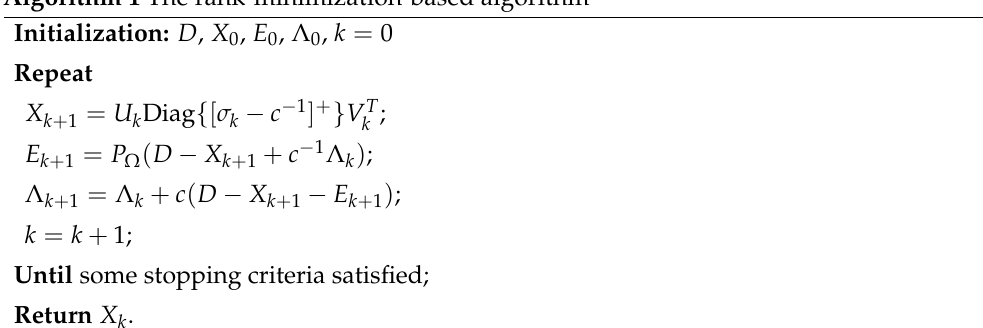
Algorithm 1 The rank-minimization-based